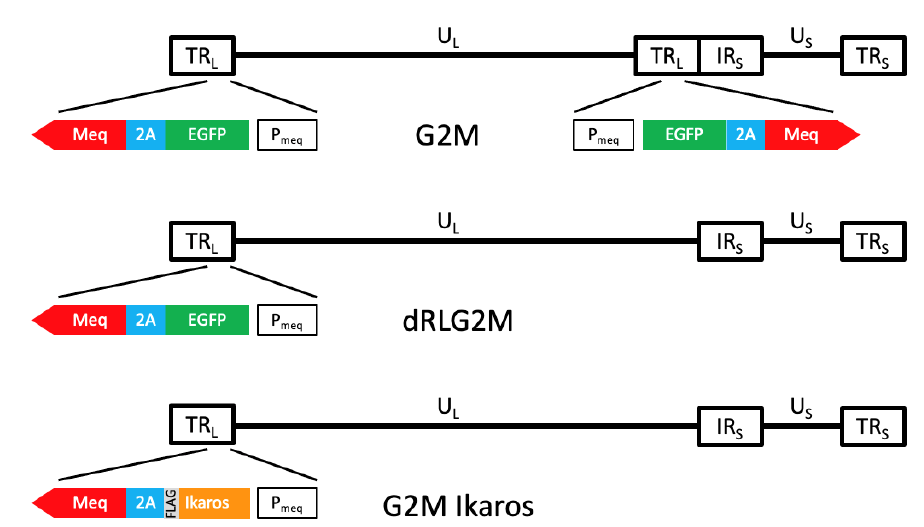
Figure 1. A schematic presentation of the recombinant MDVs. G2M is the base infectious BAC clone containing the entire Md5 strain MDV genome with EGFP inserted immediately 3 ’ of the Meq start codon and separated from Meq by a 2A self-cleaving peptide. Next, dRLG2M was generated by removing one repeat long (RL) copy. Finally, G2M Ikaros was generated by replacing EGFP with either the wild-type or mutant IKZF1 allele.